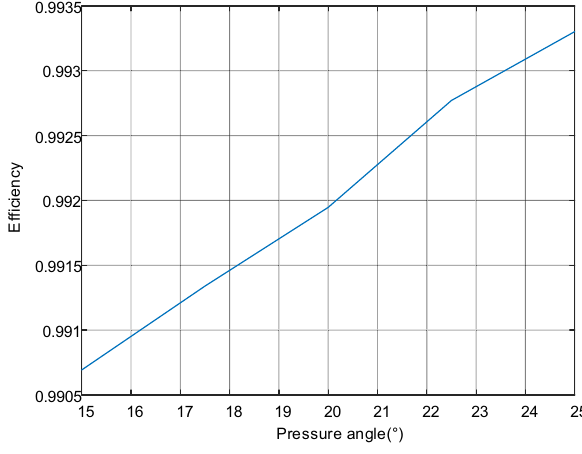
Fig. 9 Influence of modulus on transmission efficiency